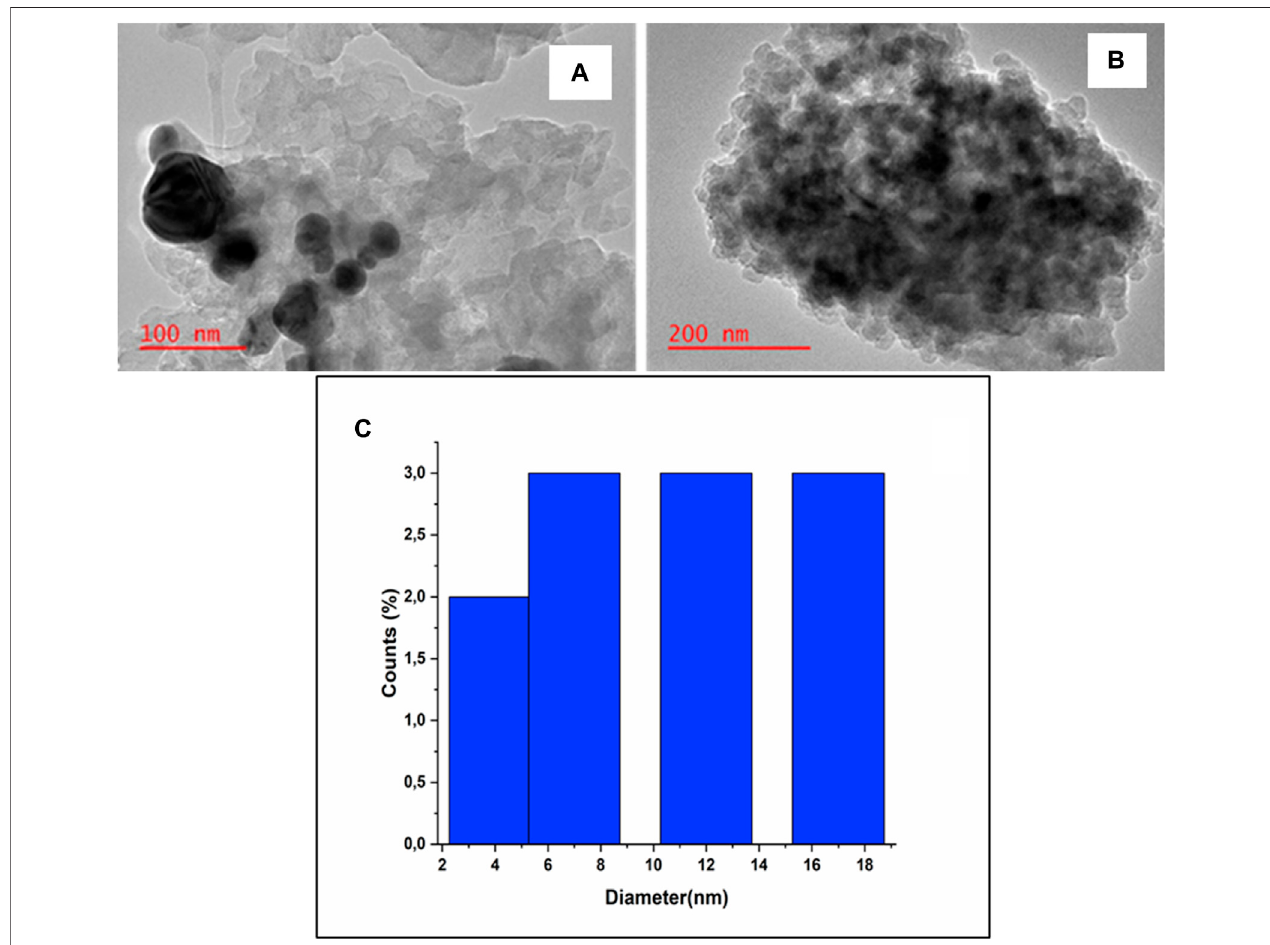
FIGURE 3 | TEM images of: (A) gCN and (B) gCN-AgPVP, (C) histogram particle size distribution.